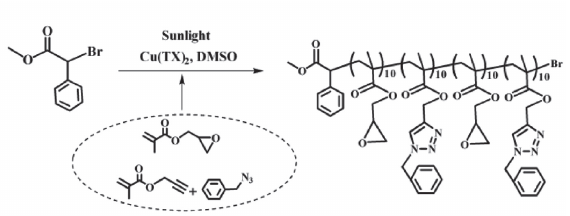
Figure 13. Concurrent ATRP and side group modification by CuAAC click chemisty. Adapted with